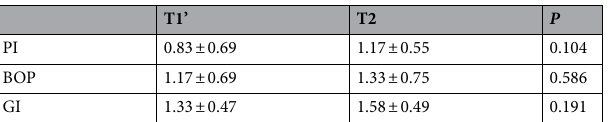
Table 2. The scores of the peri-implant tissue condition. T1’: Immediate prosthetic restorations; T2: 12 months after prosthetic restorations.